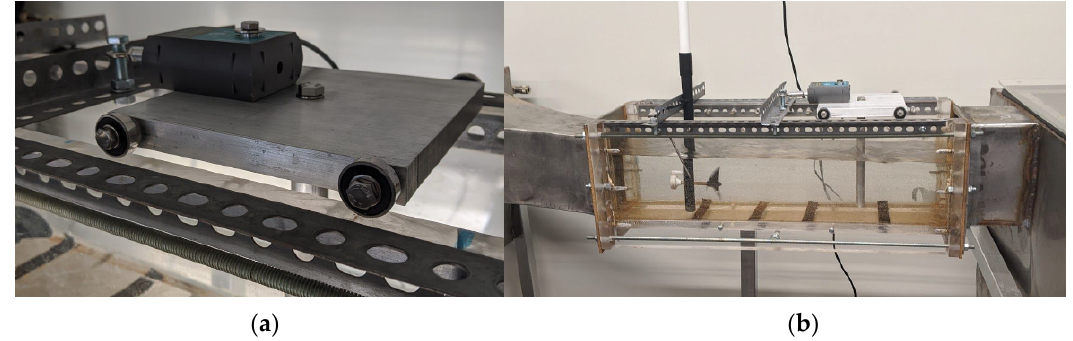
Figure 16. The figure on the left panel ( a ) shows the force sensor supported by the aluminum platform (sled) with its wheels placed along the wall of the observation chamber. The panel ( b ) on the right shows the complete setup of the drag sensor secured on the observation chamber with the flow meter placed upstream to allow simultaneous measurements of flow speed and drag forces. The water flows from left to right.